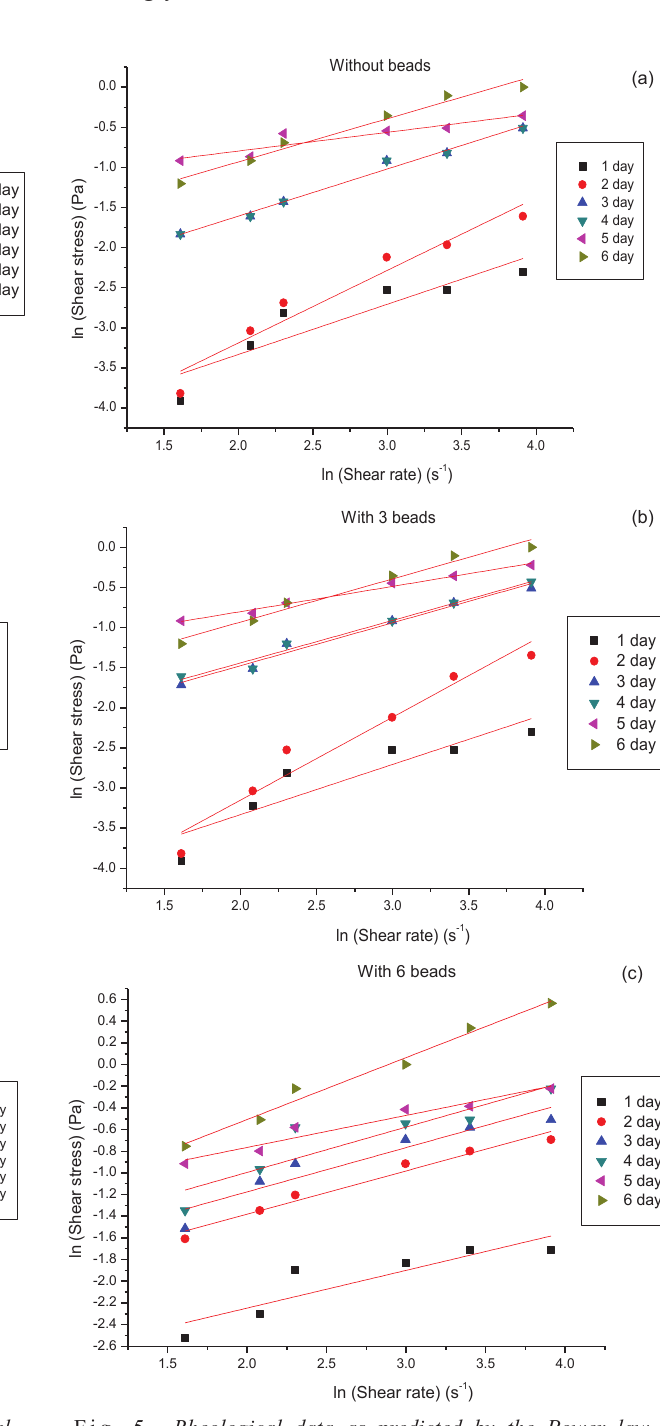
Fig. 4 – Rheological data as predicted by Casson model when cells grown without beads (a), with 3 beads (b), and 6 beads (c)